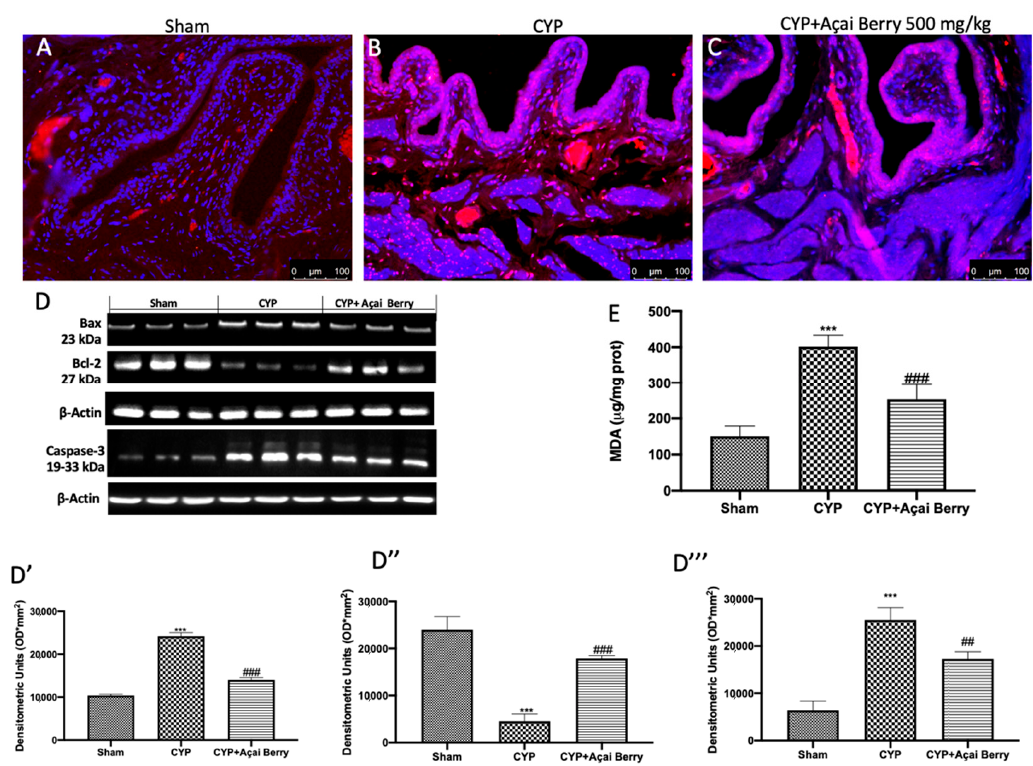
Figure 3. Açai berry modulates CYP-induced apoptosis pathways. TUNEL staining of ( A ) sham, ( B ) CYP, and ( C ) açai berry treatments. Western blot analysis of Bax, Bcl-2, and caspase 3 ( D ) and densitometric analysis (respectively, D’ , D’’ , D’’’ ). ( E ) MDA levels. *** p < 0.001 vs. sham; ## p < 0.01 vs. CYP; ### p < 0.001 vs. CYP.